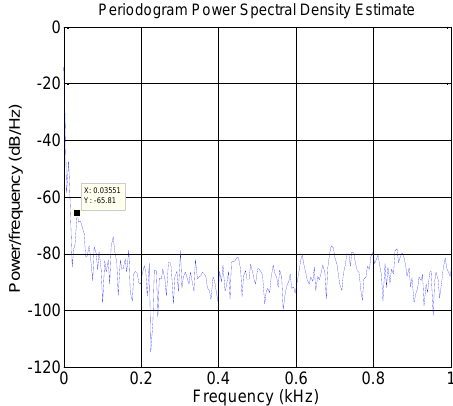
Fig. 31. Acceleration on OZ direction periodogram.